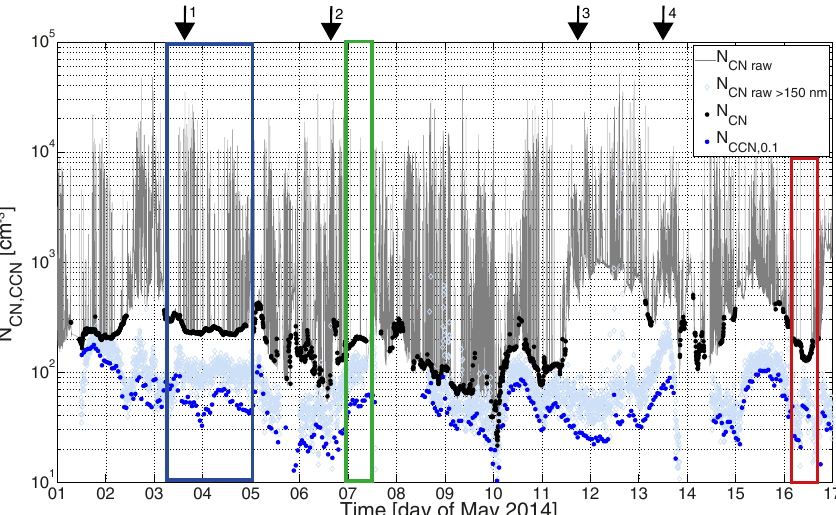
Figure 4. Time series of N CN raw (grey) and N CN (i.e. the filtered data, black) as well as N CN raw > 150nm (light blue) and N CCN , 0 . 1 (dark blue). The coloured boxes mark the three periods of measurements that were used for further analysis. The arrows at the top indicate the four overflight times of the Polar 6 research